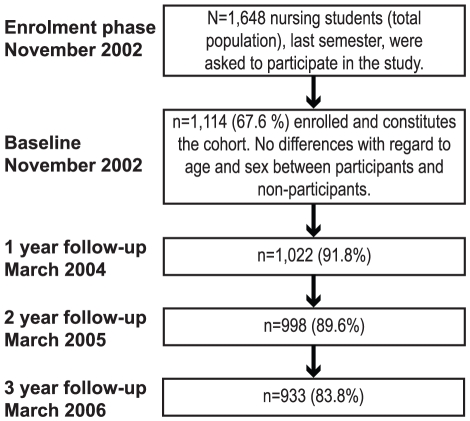
Flow of the participants and questionnaire distribution.